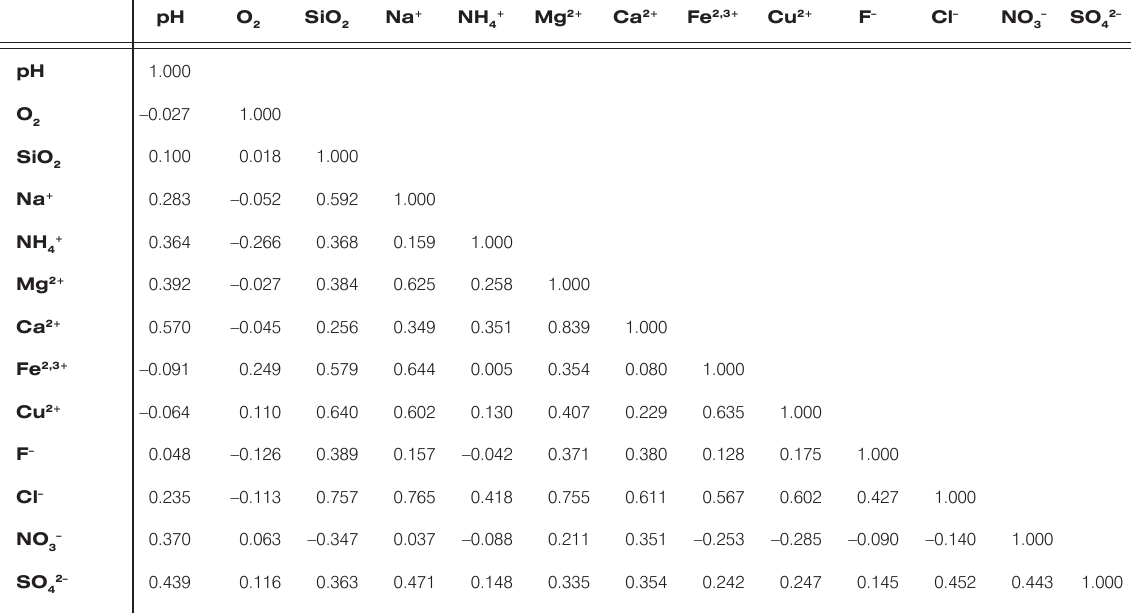
Table 6. The Pearson correlation matrix for the microelements in water–steam samples.